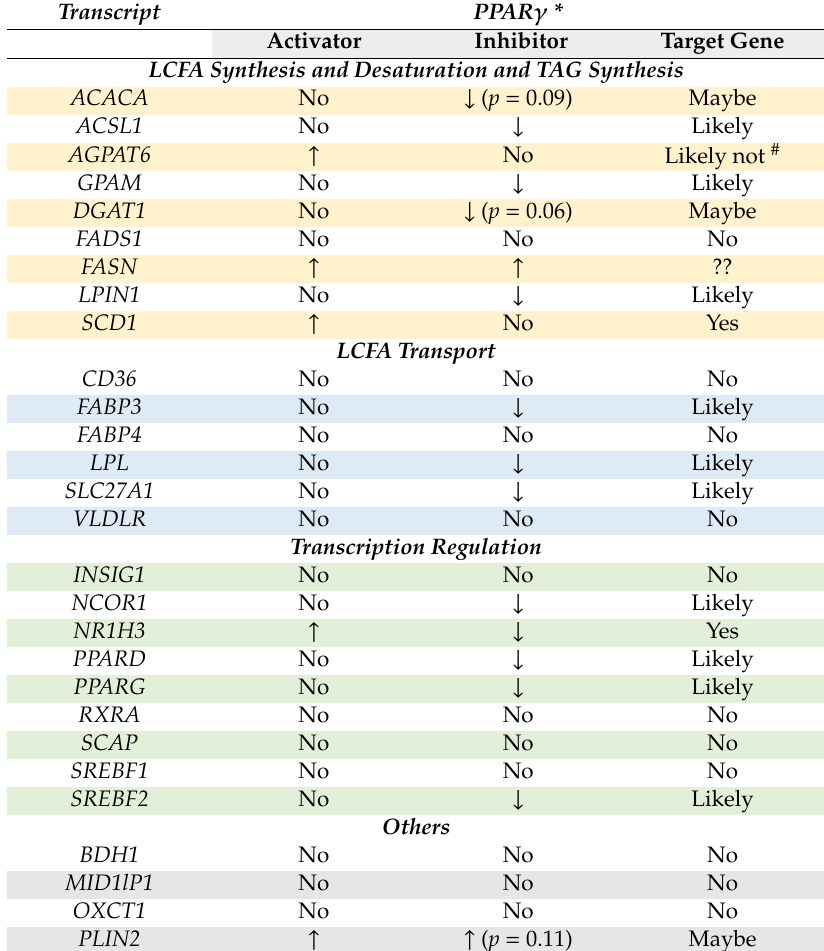
Table 1. Statistical e ff ect of 12 h treatment of primary goat mammary epithelial cells with a PPAR γ agonist (i.e., 50 µ M Rosiglitazone) and antagonist (i.e., 50 µ M GW9662) on transcription of genes related to milk fat synthesis. Transcript PPAR γ * Activator Inhibitor Target Gene LCFA Synthesis and Desaturation and TAG Synthesis